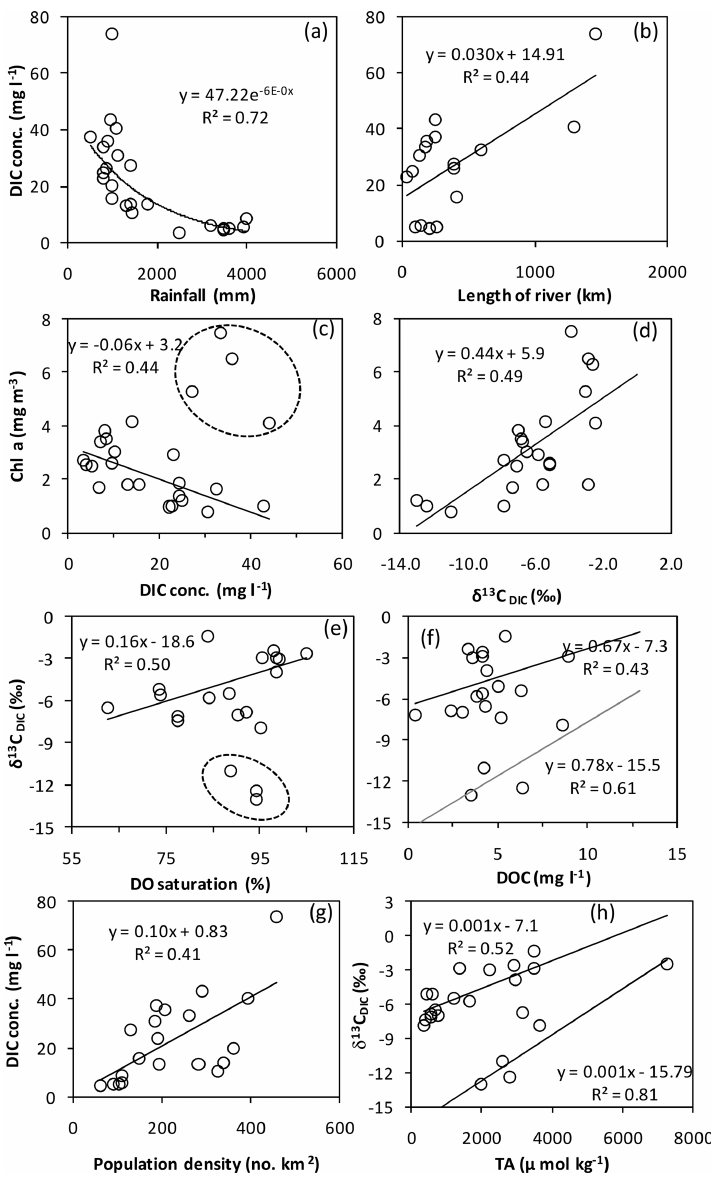
Figure 4. (a) Exponential decrease and (b) linear increase of dissolved inorganic carbon (DIC) concentrations with increasing rainfall over the catchment and the length of the river, respectively. (c) Inverse and (d) linear relationships of chlorophyll a (Chl a ) with concentrations and δ 13 C of DIC, respectively. Significant linear relationships of δ 13 C of DIC with (e) dissolved oxygen (DO) saturation and (f) dissolved organic carbon (DOC) concentration. Linear relationships observed between (g) DIC concentrations and population density in the catchment, and (h) total alkalinity and δ 13 C of DIC in the Indian monsoonal rivers during the study period. Ovals with dashed lines indicate the outliers which were not included in the regression equations. Rivers of the northwestern region of India showed linear relationships, as shown by the other Indian rivers but with a different slope ( f–h